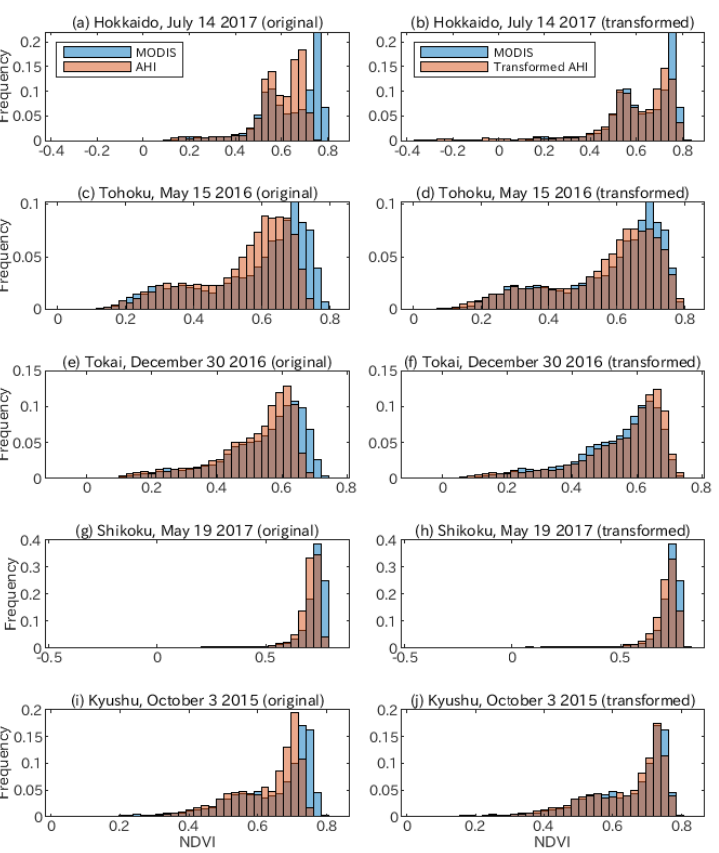
Figure 6. Relative frequency distributions for the worst date, where the absolute value of the averaged transformed AHI NDVI minus the averaged MODIS NDVI was maximal, at each site.